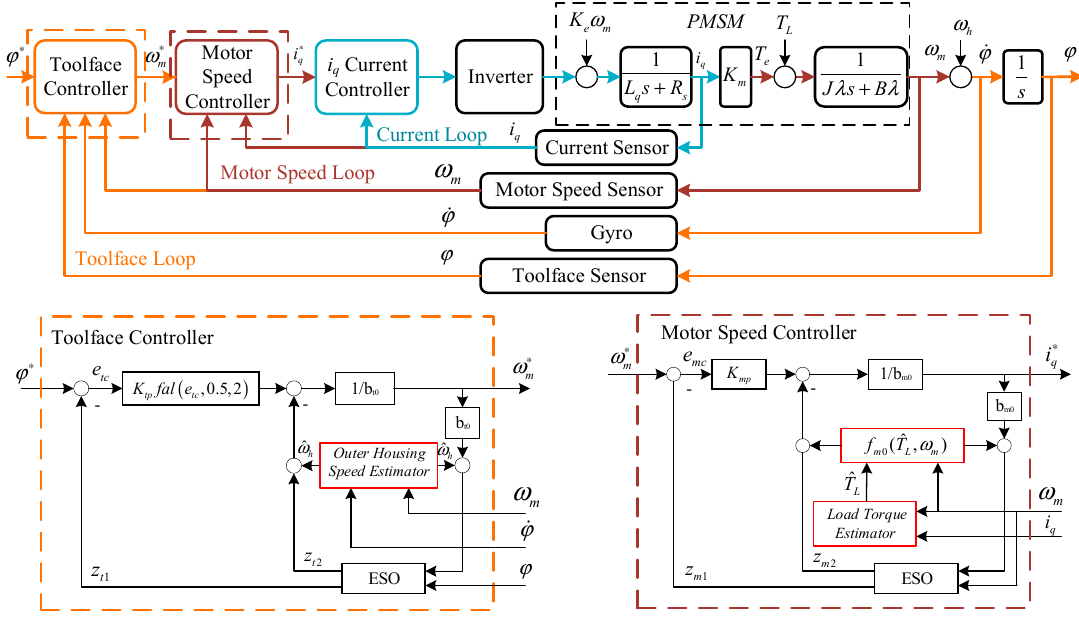
Figure 5. The scheme of the toolface control method .